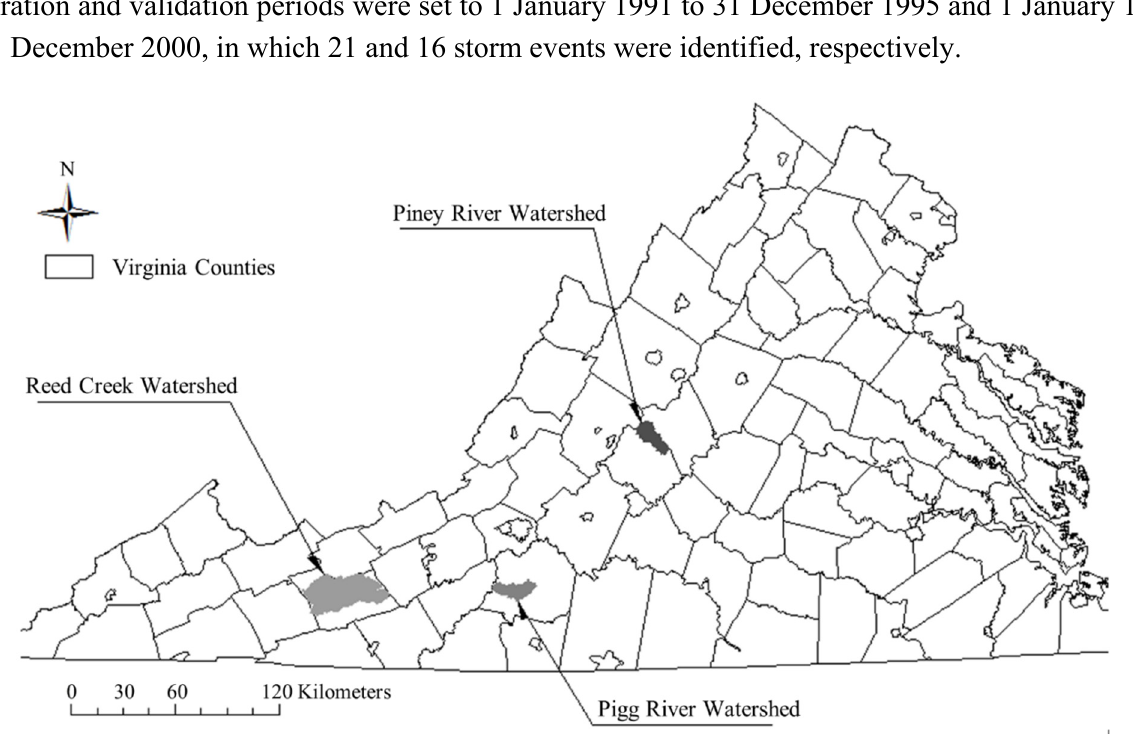
Figure 2. Locations of the study